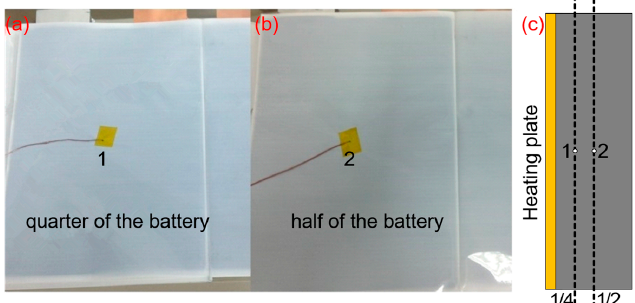
Figure 6. Position of the thermocouples inside the battery: ( a ) quarter point of the battery; ( b ) halfway within the battery; ( c ) diagram of the thermocouples inside the battery.